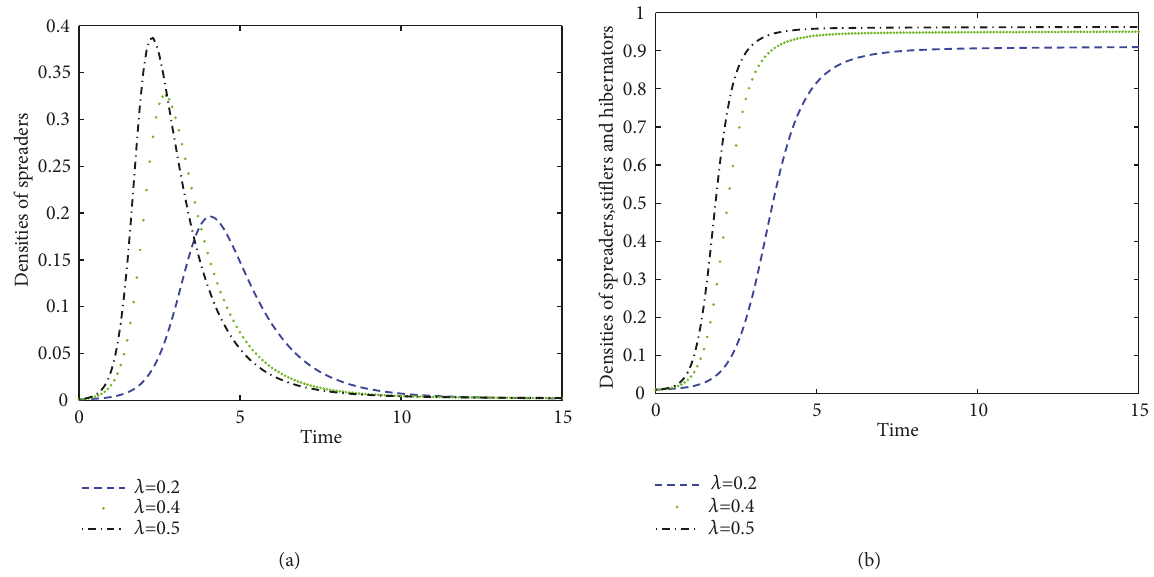
Figure 6: Numerical simulations of (3) with 𝛽 = 0.1 , 𝛼 = 0.1 , 𝛿 = 0.1 , 𝜉 = 0.05 , and 𝜂 = 0.1 and different spreading rates 𝜆 in the network with the Poisson degree distribution. (a) The trajectories of the densities of spreaders. (b) The trajectories of the densities of spreaders, stiflers, and